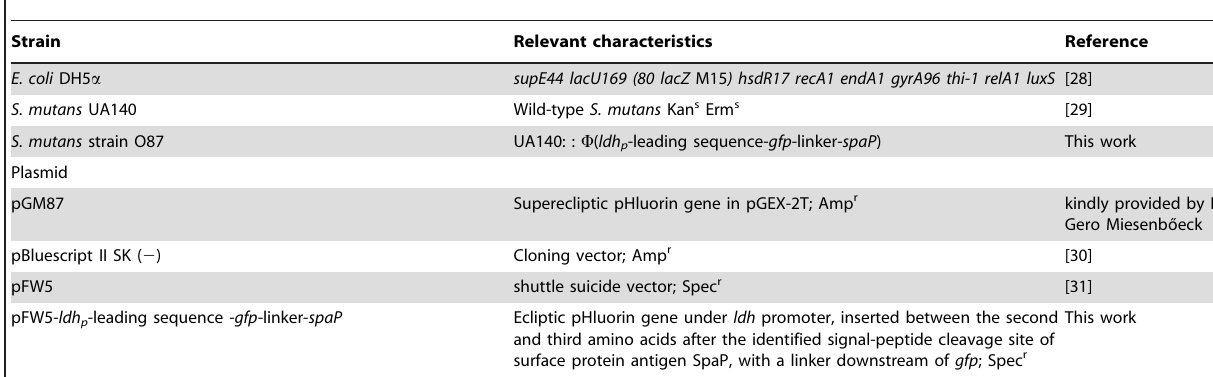
Table 2. Strains and plasmids used in this